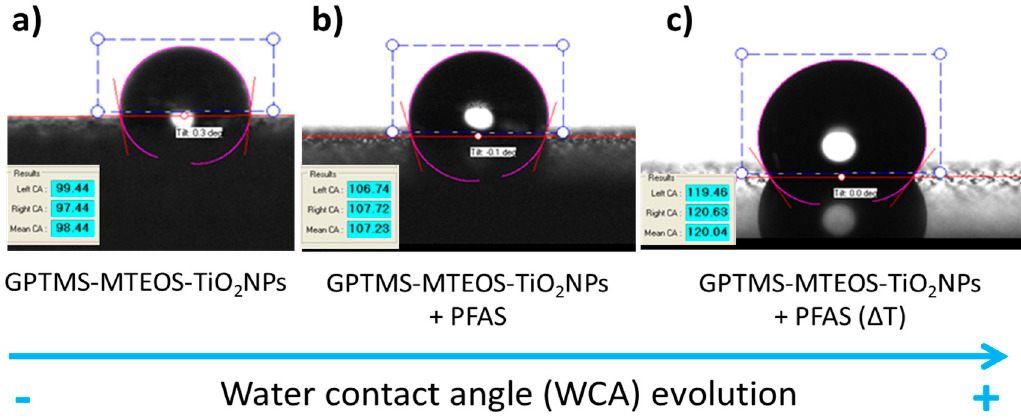
Figure 5. Comparison between the water contact angle images recorded for the films obtained when aluminum substrates are coated with GPTMS-MTEOS-TiO 2 NPs ( a ), GPTMS-MTEOS-TiO 2 NPs-PFAS ( b ), and GPTMS-MTEOS-TiO 2 NPs-PFAS after thermal treatment ( c ).